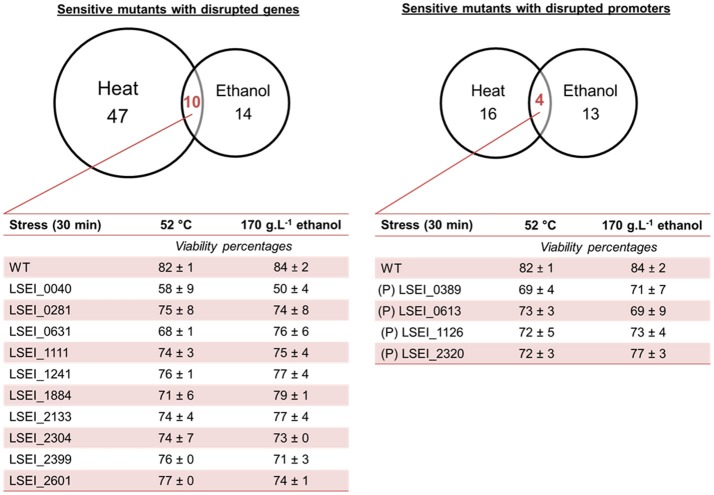
Venn diagram of L. paracasei mutants sensitive to heat (52°C, 30 min) and ethanol (170 g.L−1, 30 min) mild stresses. Corresponding viabilities using propidium iodide labeling are indicated only for mutants sensitive to the 2 stresses (at least 2 biological repeats). (P), intergenic insertion mutant (putative promoter). The predictive function of each gene is reported in Table 5.